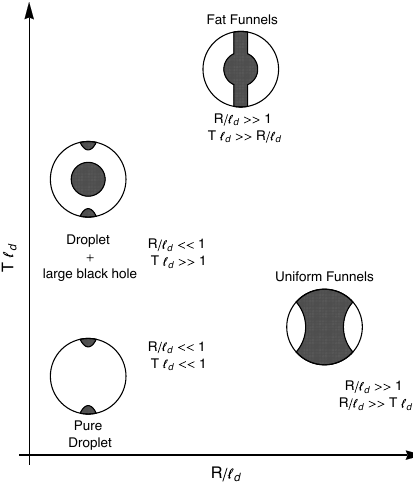
Figure 2 . Phase diagram for general R=‘ d ; T‘ d . The boundaries between phases are not shown as their locations are unknown. We cannot rule out the possibility that additional phases (such as thin funnels) also dominate in certain regimes, though comparison with known results for Kaluza-Klein black holes [38{46]. makes this seem unlikely. The absence of a Gregory-La(cid:13)amme instability for d = 3 boundary dimensions suggests that in that case the fat and uniform funnels are connected by a crossover, though in higher dimensions we expect a sharp phase